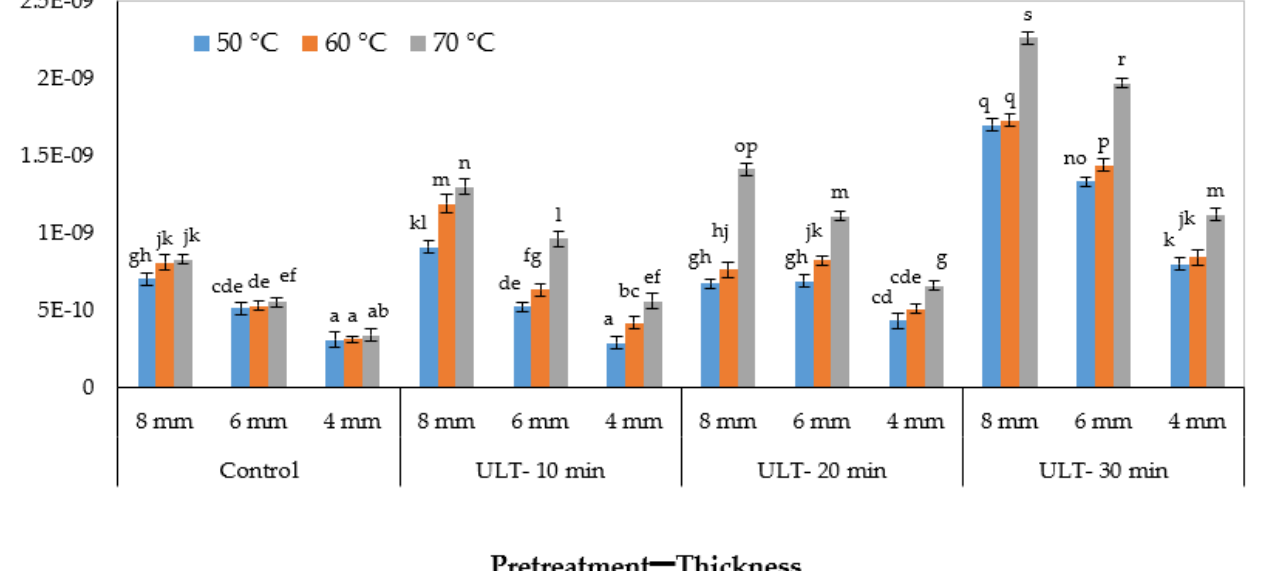
Figure 2. The value of D eff under different conditions for drying kiwifruit slices.